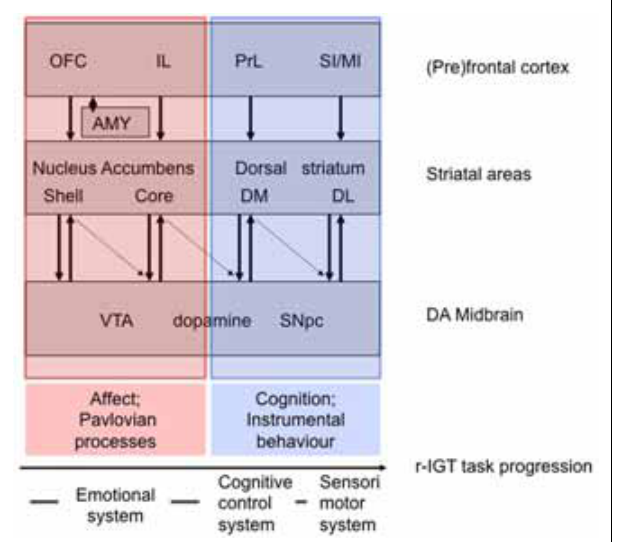
FIGURE 2 | Hypothetical neurobehavioral model of task-progression in the r-IGT (Yin and Knowlton, 2006;Yin etal., 2008). It should be noted that the cingulate areas and insular cortex are not included (see New Directions for the r-IGT). Furthermore the subdivisions of the OFC are not shown (see van den Bos etal., 2013b). In transparent red, the emotional system is shown, of which striatal areas are involved in Pavlovian behavior (seeYin etal., 2008): while the shell is involved in immediate (hedonic) responses (stimulus-outcome; (un)conditioned consummatory/hedonic responses), the core is involved in anticipatory/preparatory behavior (stimulus–stimulus relation). In transparent blue, the cognitive control system [dorsomedial (DM) striatum; action-outcome; goal-directed behavior] and sensorimotor/habit system [dorsolateral (DL) striatum; stimulus-response; habit-like behavior], of which striatal areas are involved in instrumental behavior.Thus far, we have not trained animals to the point of showing habitual behavior. Arrows indicate mutual interactions between midbrain dopaminergic areas and striatal areas, while the dotted arrows indicate disinhibition of dopaminergic areas by striatal areas [seeYin and Knowlton (2006) for discussion]. Dopaminergic projections to the prefrontal cortex are not shown. Also the interaction with the serotonergic (5-HT) system is not shown (see for discussion: Homberg etal., 2008; Koot etal., 2012; van den Bos etal., 2013b). Abbreviations: amy, amygdala; OFC, orbitofrontal cortex; IL, infralimbic cortex; PrL, prelimbic cortex; SI/MI, primary and sensory motor cortices;VTA, ventral tegmental area; SNPc, substantia nigra pars